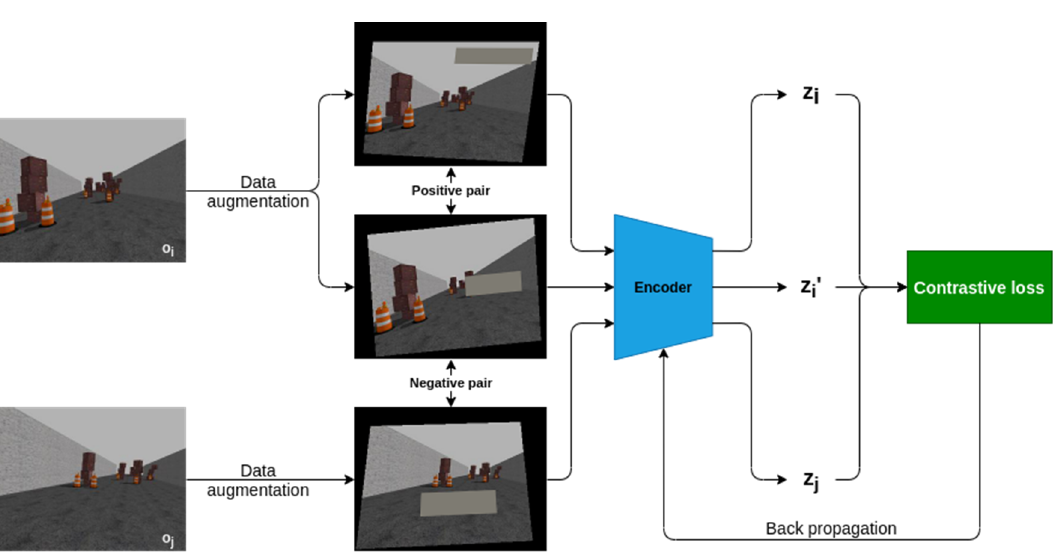
Figure 7. The process of training the encoder.